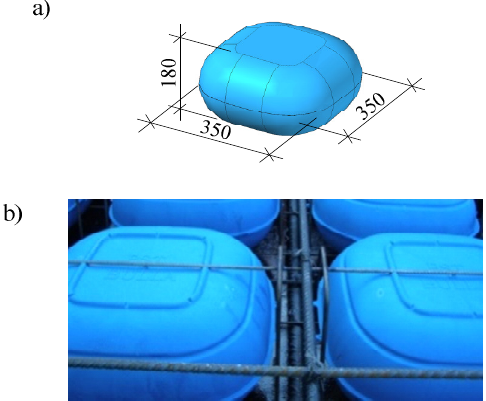
Table 1. Characteristics of the slab